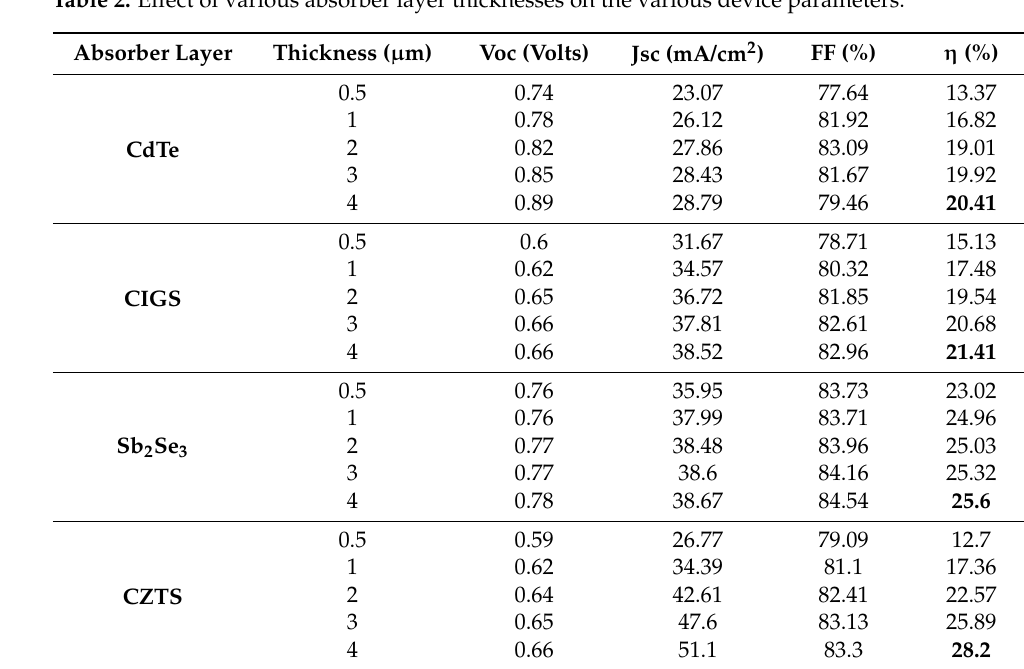
Figure 2. Impact of absorber layer thickness on ( a ) Voc, ( b ) Jsc, ( c ) FF, and ( d ) efficiency. Table 2. Effect of various absorber layer thicknesses on the various device parameters.